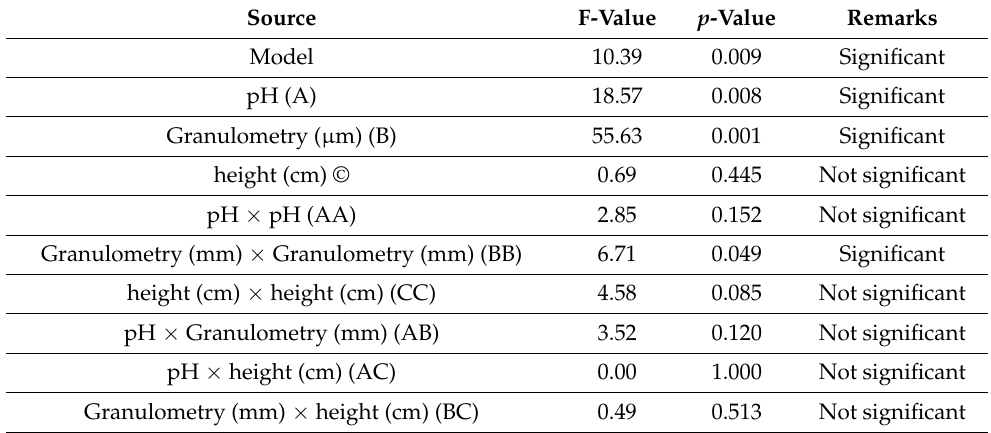
Table 2. Regression of the response surface: COD RP (%) as a function of the particle size ( µ m), height (cm) and pH.